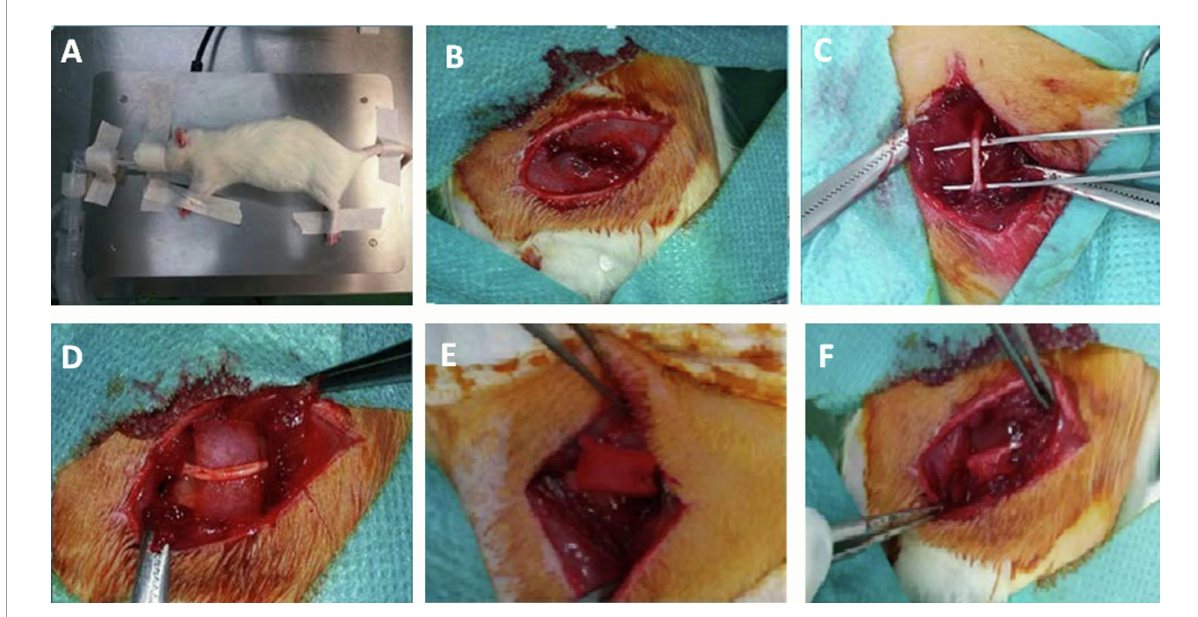
FIGURE1 Surgical procedure. (A) Rat in lateral decubitus. A mask was used for the administration of the anesthetic. (B) Incision to the biceps femoris muscle. (C) Exposed sciatic nerve. (D) Biomaterial placed below the sciatic nerve. (E) Biomaterial sleeve around the sciatic nerve. (F) Biomaterial sleeve attached to the